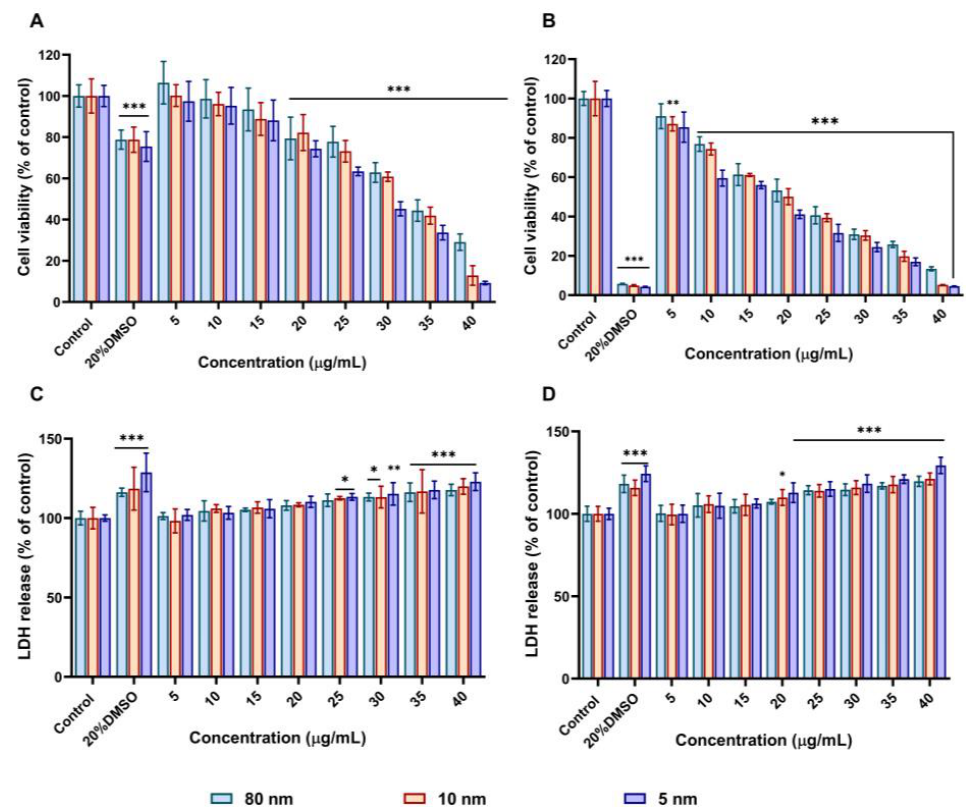
Figure 2. Cell viability and lactate dehydrogenase (LDH) release of A549 cells treated with 5 – 40 µg/mL of different sizes of AuNPs measured using MTT and LDH assays. Percentage of cell viability after incubation with AuNPs for ( A ) 24 h and ( B ) 48 h. Percentage LDH release in media after incubation with AuNPs for ( C ) 24 h and ( D ) 48 h. 20% DMSO was used as a positive control. Plotted graphs represent the means ± SD of six independent experiments. Bars with an asterisk (*) show statistical differences (* p < 0.05, ** p < 0.01, and *** p < 0.001) compared with the control.